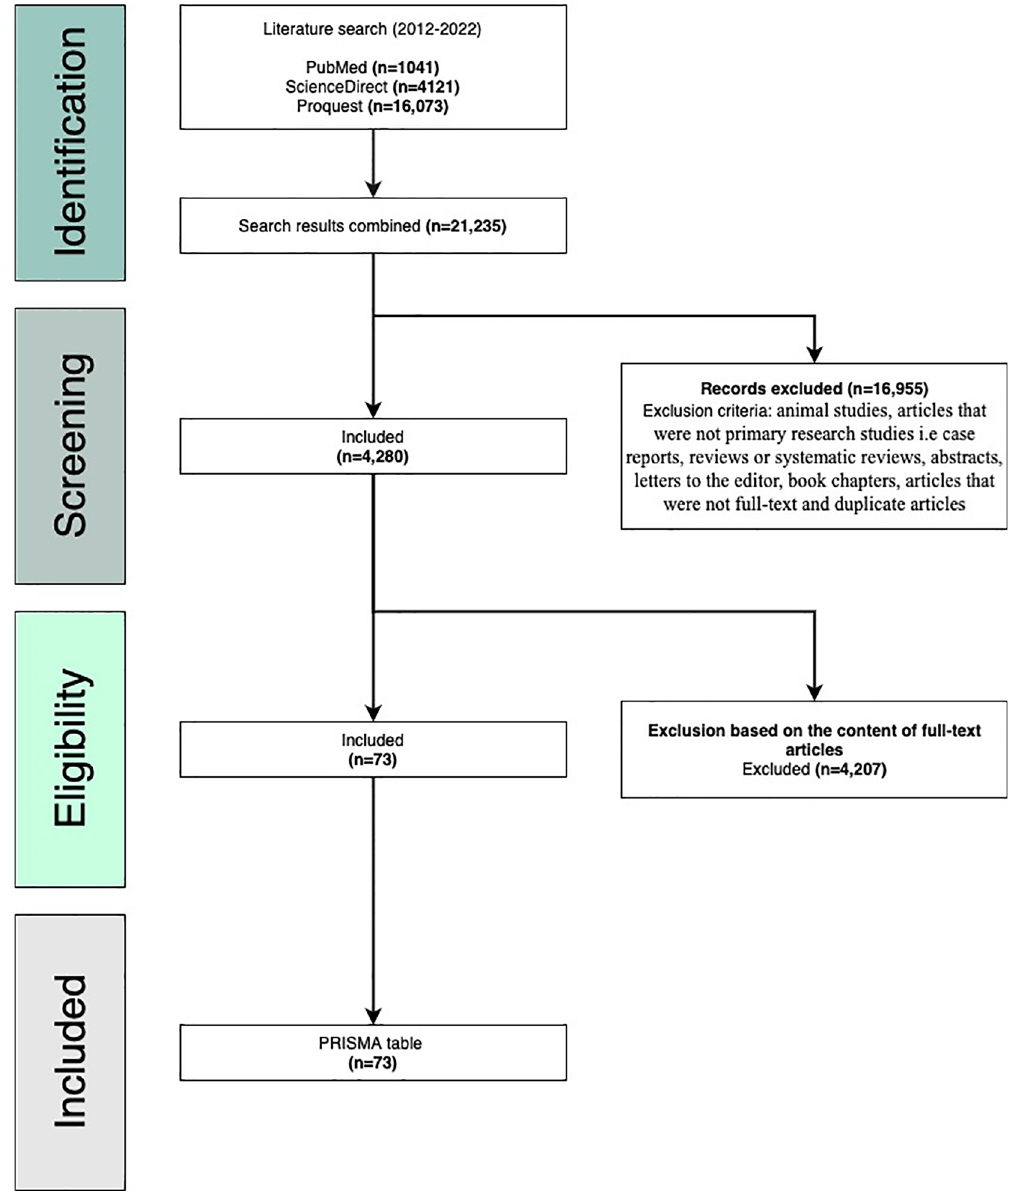
Figure 1. Preferred Reporting Items for Systematic Reviews (PRISMA) flow